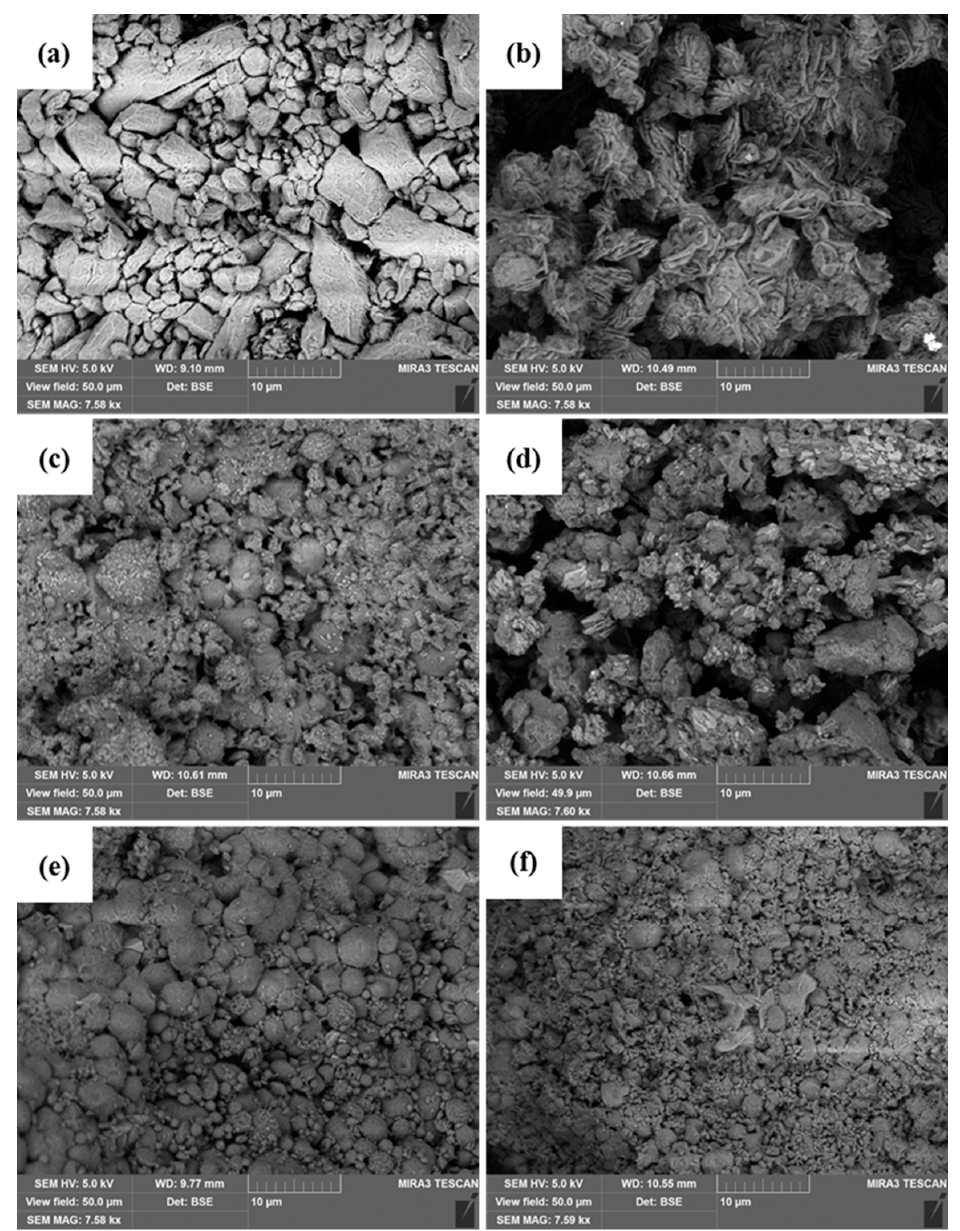
Figure 3. Scanning electron microscopy (SEM) microphotographs of the non-cross-linked MP5700 ( a ) and cross-linked MP5704 ( b ), MP5706 ( c ), MP5708 ( d ), MP5008 ( e ), and MP4008 ( f ) chitosan